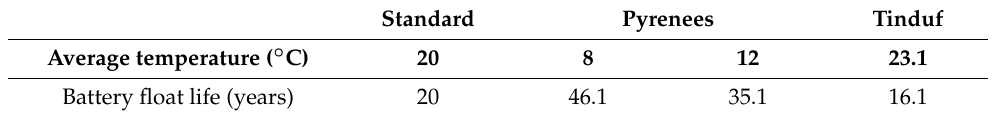
Table 1. Float life at different temperatures considering Arrhenius law.